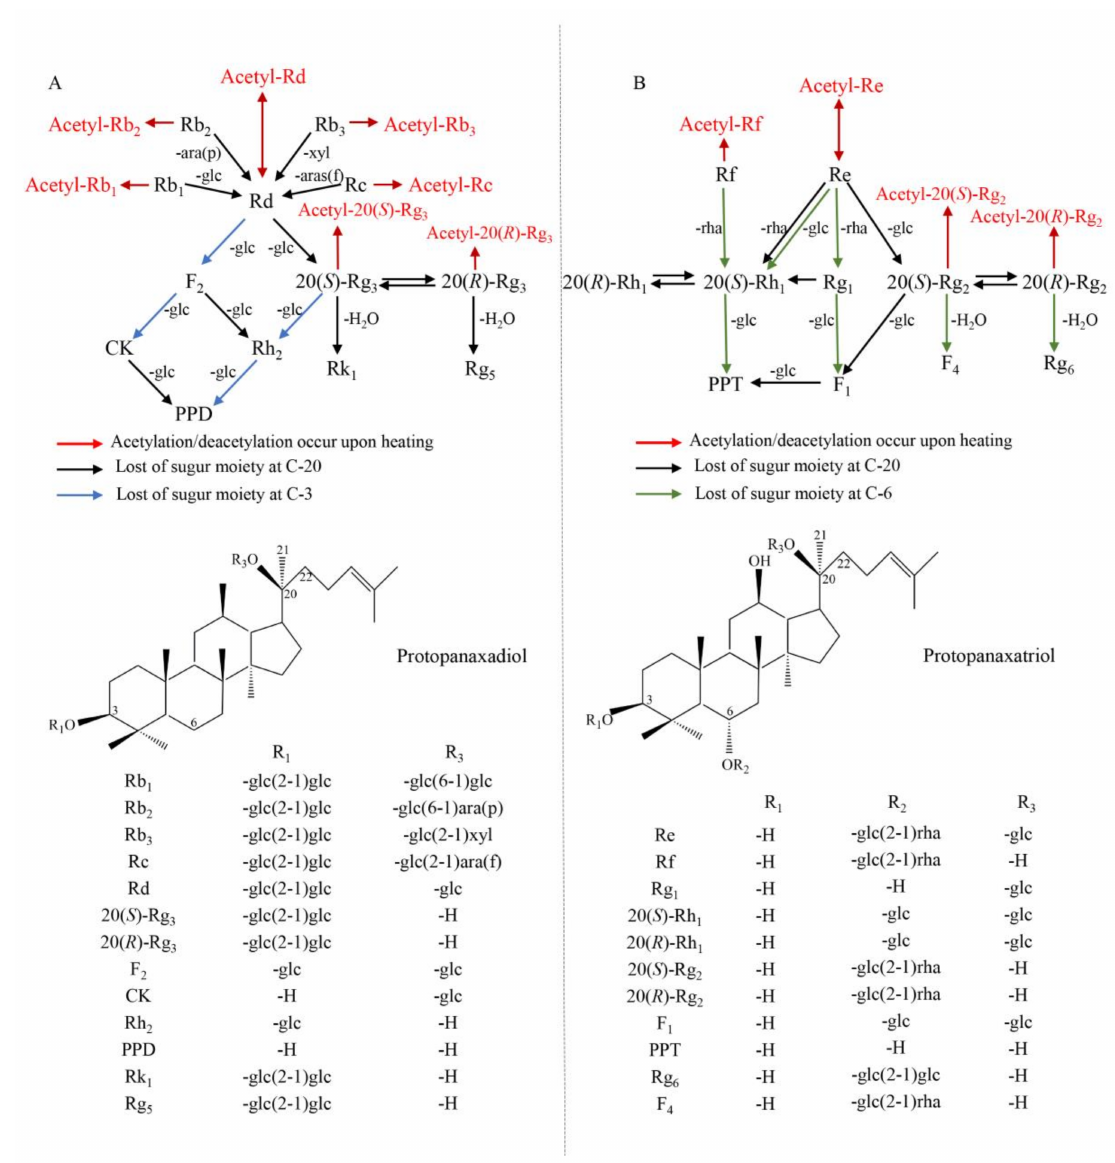
Figure 4. Chemical structures and possible transformation mechanisms of ginsenosides in heated ginseng flowers. ( A ) Protopanaxadiols; ( B ) Protopanaxatriols. Ara(f), α - L -arabinofuranosyl; Ara(p), α - L -arabinopyranosyl; Glc, α - D -glucopyranosyl; Xyl, β - L -xylopyranosyl; Rha, α - L -ahamnopyranosyl. Chemical links between C-20 and C-22 of F 4 and Rg 5 , and between C-20 and C-21 of Rg 6 and Rk 1 are double